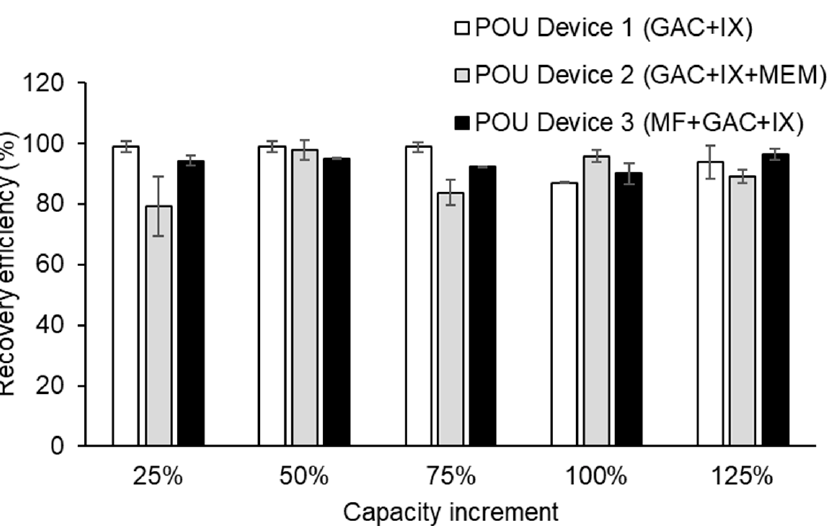
Figure 2. Mean particle recovery following each 1 L sample filtered through duplicates of POU Device 1 (GAC + IX; A), POU Device 2 (GAC + IX + MEM; B), and POU Device 3 (MF + GAC + IX; C). Vertical bars represent ± one standard deviation ( n = 2).